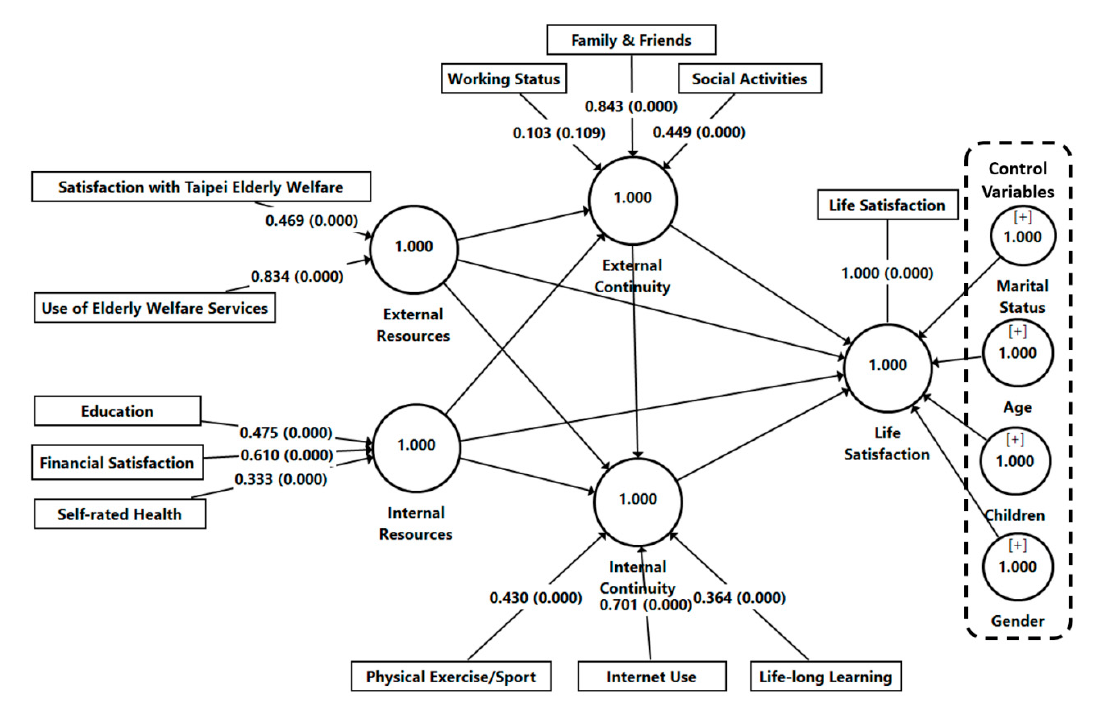
Figure 2. Measurement model. Table 3. The parameters of the measurement model.